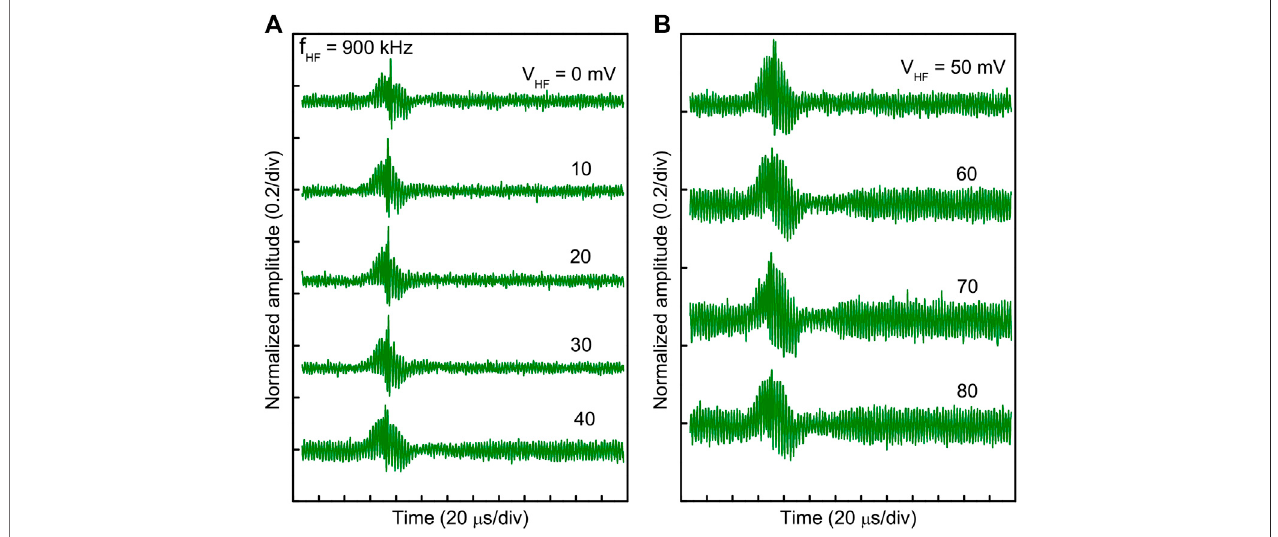
FIGURE 6 | Observed oscilloscope trace at a fi xed probe position 9 cm from the separation grid showing the transition of ion acoustic Peregrine soliton to an envelope with an increase in V HF . (A) For V HF (cid:2) 0 – 40 mV. (B) For V HF (cid:2) 50 – 80 mV.